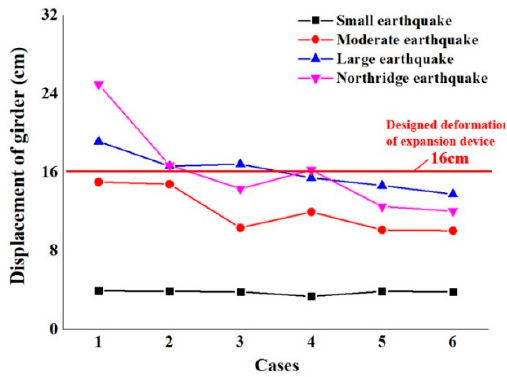
Figure 7. Displacement of girders in different cases under different earthquakes.